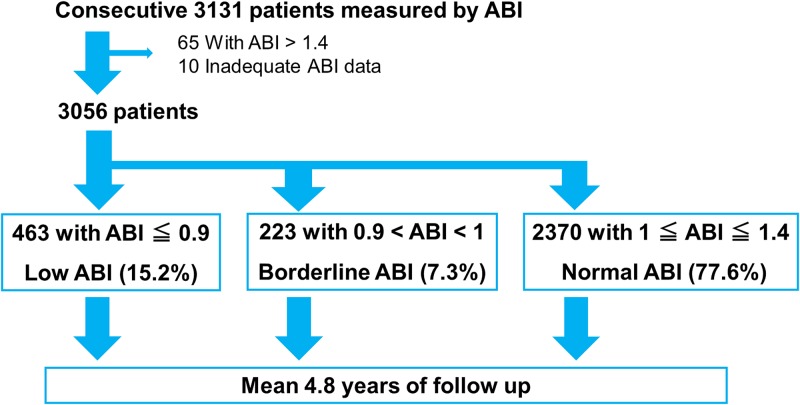
Study flowchart.